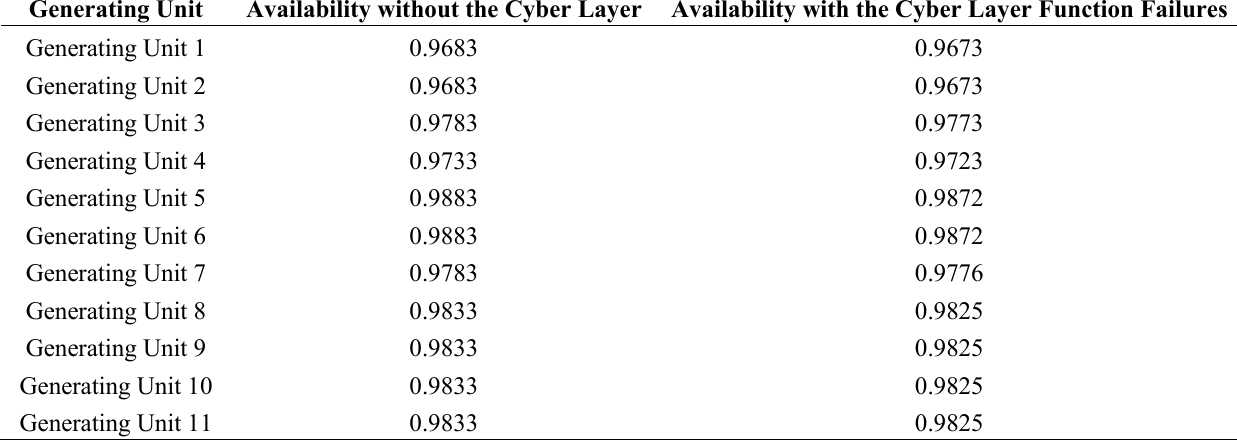
Table 6. The availability of generating units incorporating the star-ring cyber layer function failures.